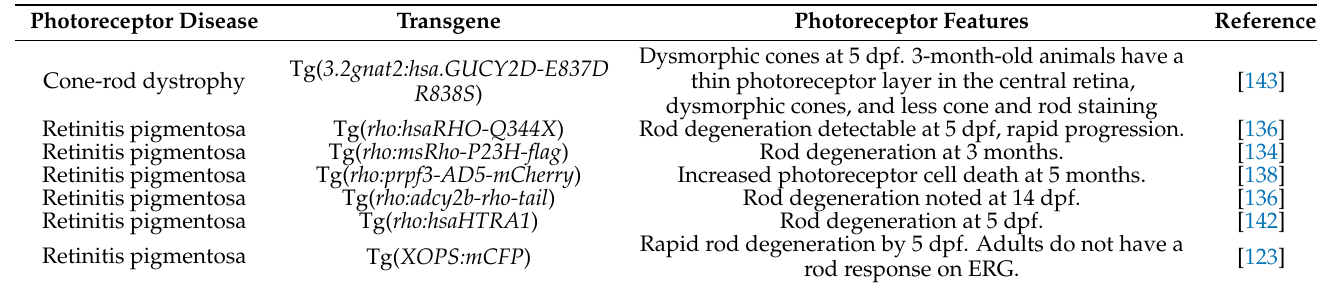
Table 3. Transgenic zebrafish models of photoreceptor